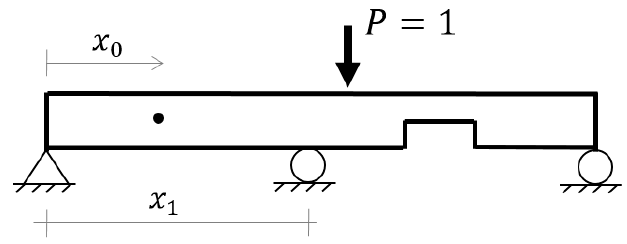
Figure 4. Example-I analysis results ( a ) recorded Deflection Influence Line (DIL) ( b ) first derivative of DIL ( c ) second derivative of DIL ( d ) beam flexural rigidity estimation